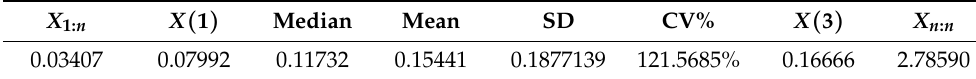
Table 3. Summary of descriptive